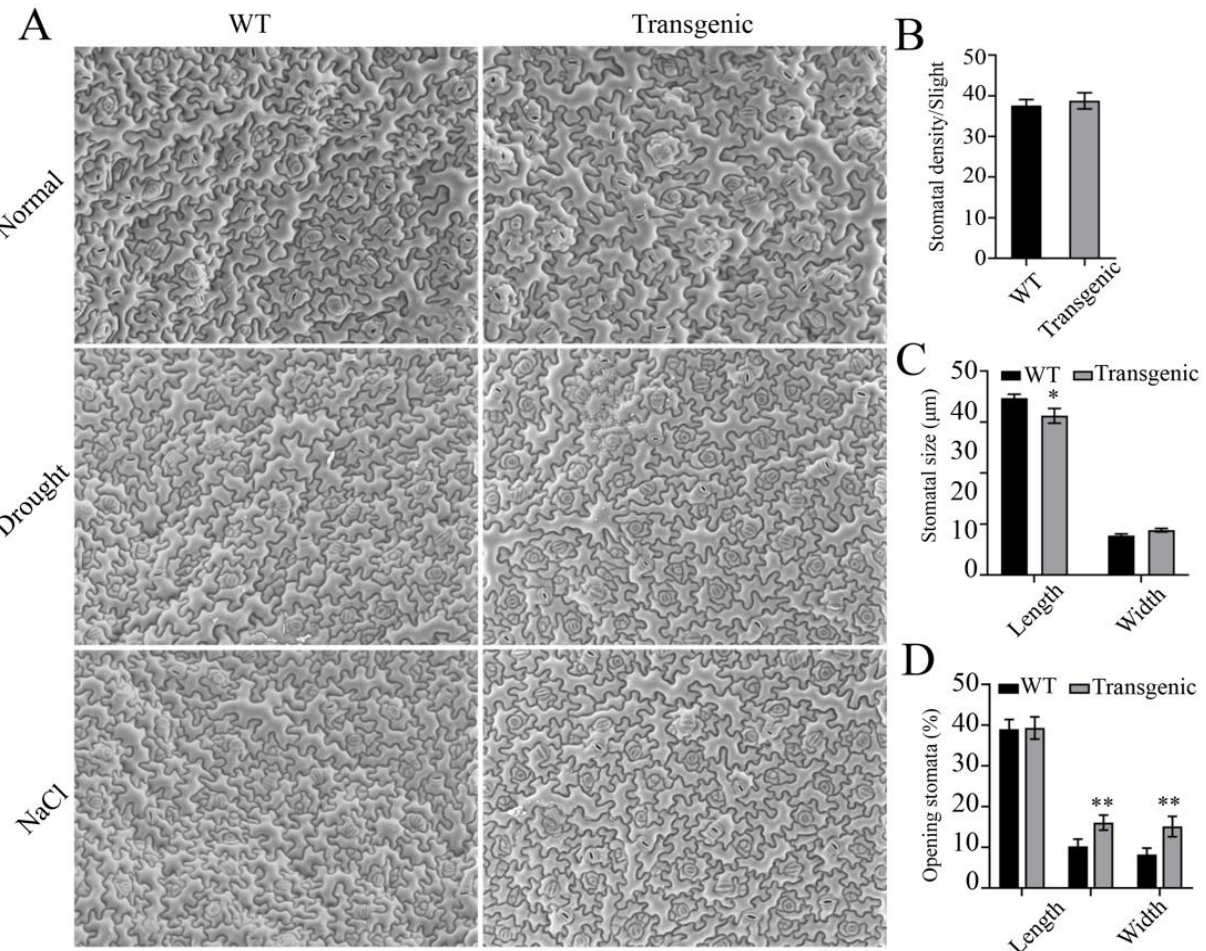
Figure 10. Stomatal phenotypes in FtMYB22 transgenic Arabidopsis (T4, T6, and T9) lines and WT lines under stress treatments. ( A ) Stomatal observation. ( B ) Stomatal density per vision. ( C ) Length and width of stoma. ( D ) Stomatal opening rate. Normal: under normal conditions. WT, wild-type. Scale bar: 400 µ m. Data are presented as mean and SD values of three independent experiments. Error bars indicate SD. ** means extremely significant difference at p < 0.01 level. * means significant difference at p < 0.05